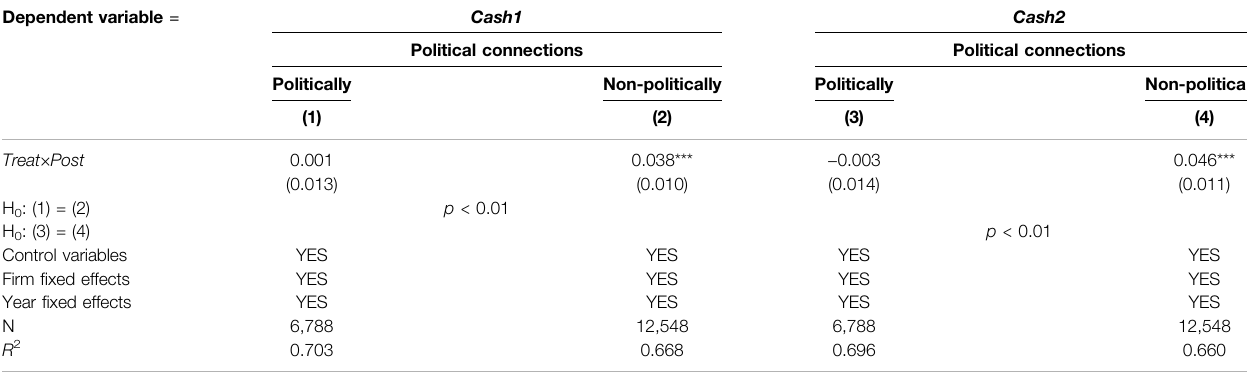
TABLE 11 | Heterogeneous Effects of environmental regulation on corporate cash holdings. Dependent variable =